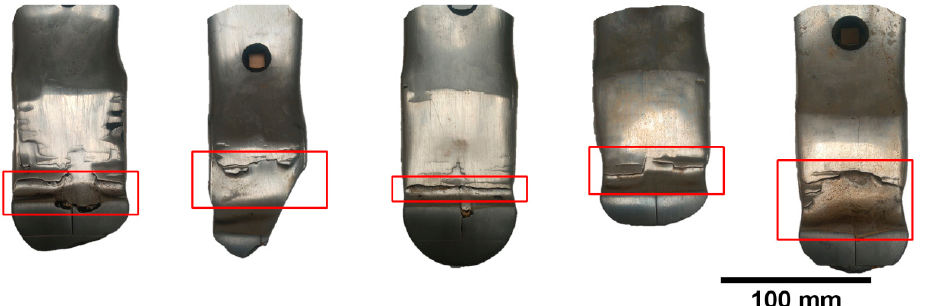
Figure 3. View of the claddings area of cultivator coulters after working in soil. Macroscopic delamination on the surface of the claddings (“wash-out” effect), visible inside frames.